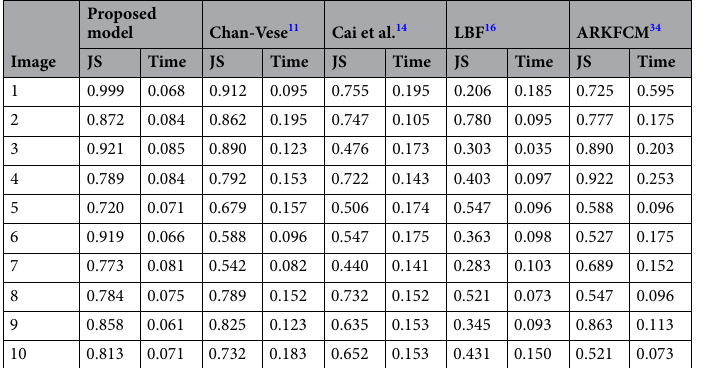
Table 1. The Jaccard similarity measure, and CPU time (seconds) of Cai et al. 14 , ARKFCM 34 , Chan-Vese 11 , LBF 16 , and of the anticipated approach on 10 different images from the Berkeley’s dataset.